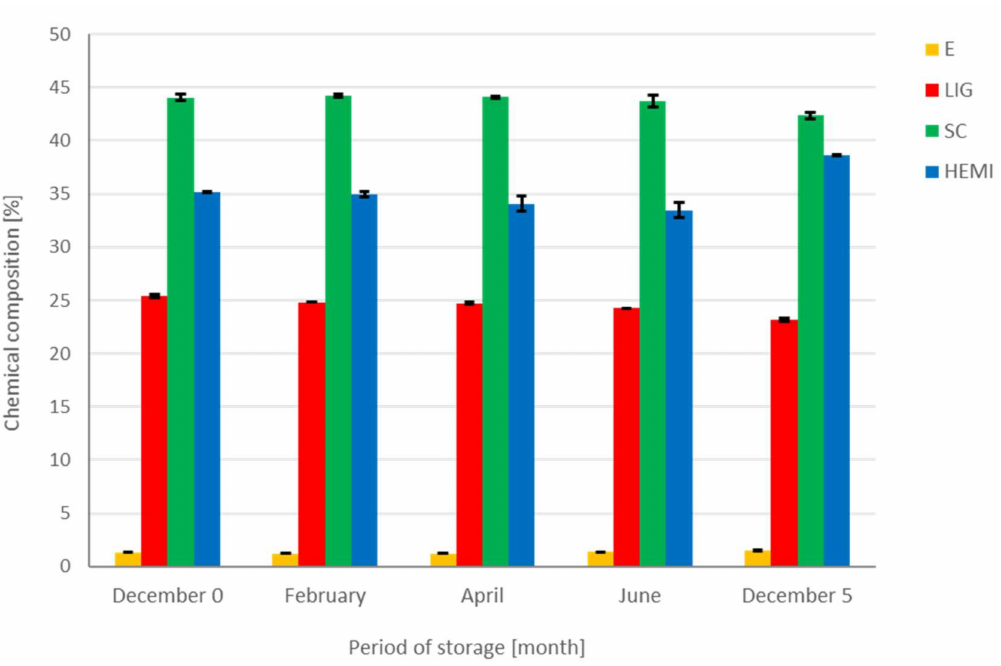
Figure 8. The change in the chemical composition of spruce wood during the storage (the whiskers at the tops of the bars mean standard deviations from arithmetic averages, the bars’ height).